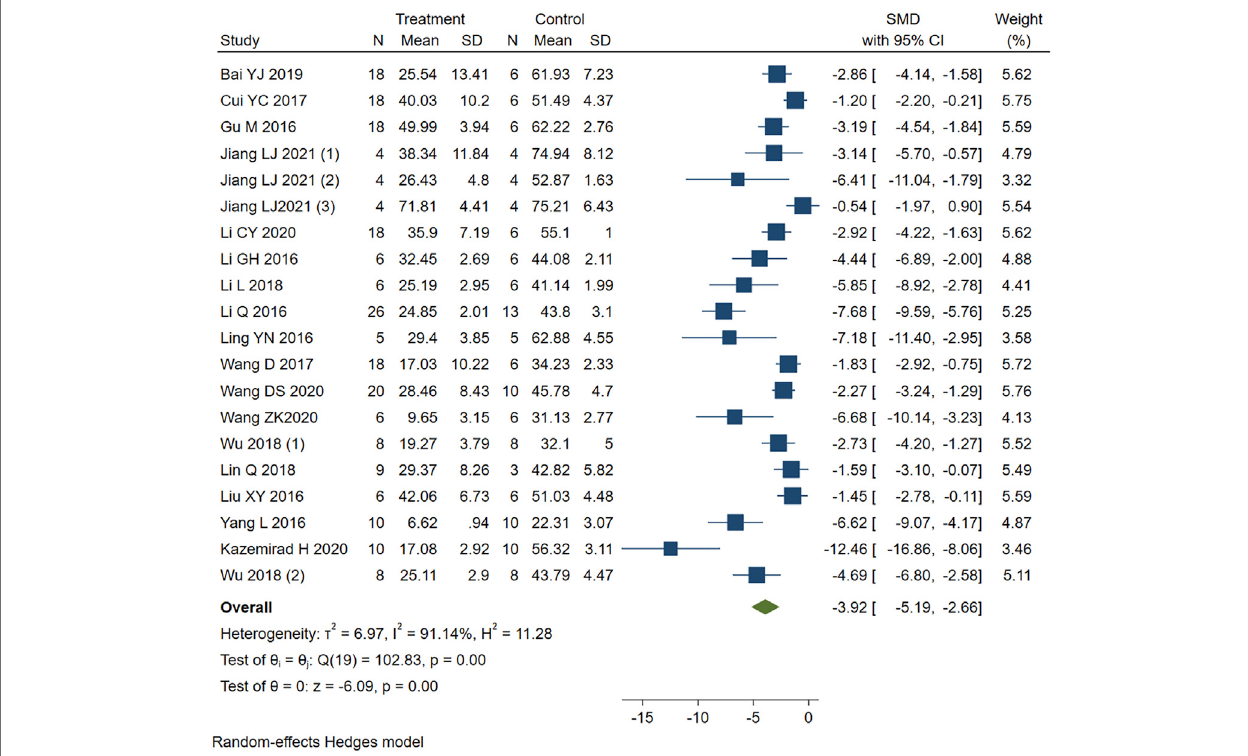
FIGURE 2 | Forest plot to study the effect of PE on infarct size. PE reduced the myocardial infarct size in MIRI animals compared with the control group (SMD = − 3.92, 95%CI: − 5.19 to − 2.66, p < 0.001). The dark squares represent the standardized mean difference (SMD) for each study. The diamonds represent the pooled SMD. 95% of the CIs are indicated by lines. The analysis was conducted using a fi xed-effects model.